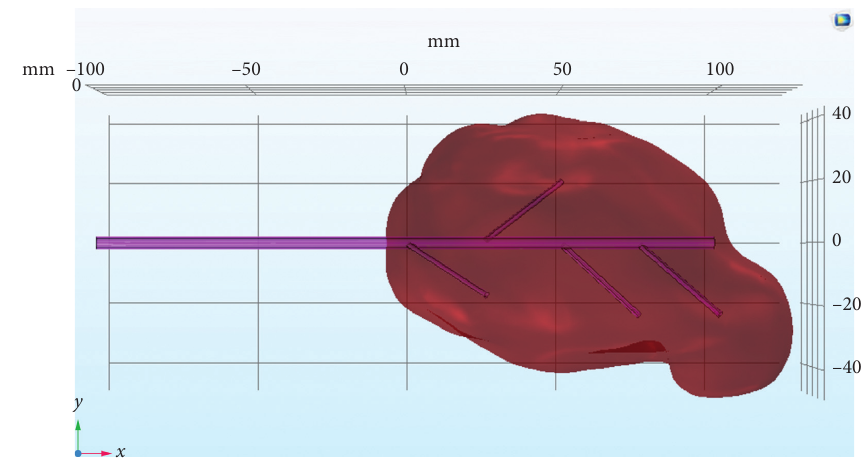
Figure 16: Side view of hematoma